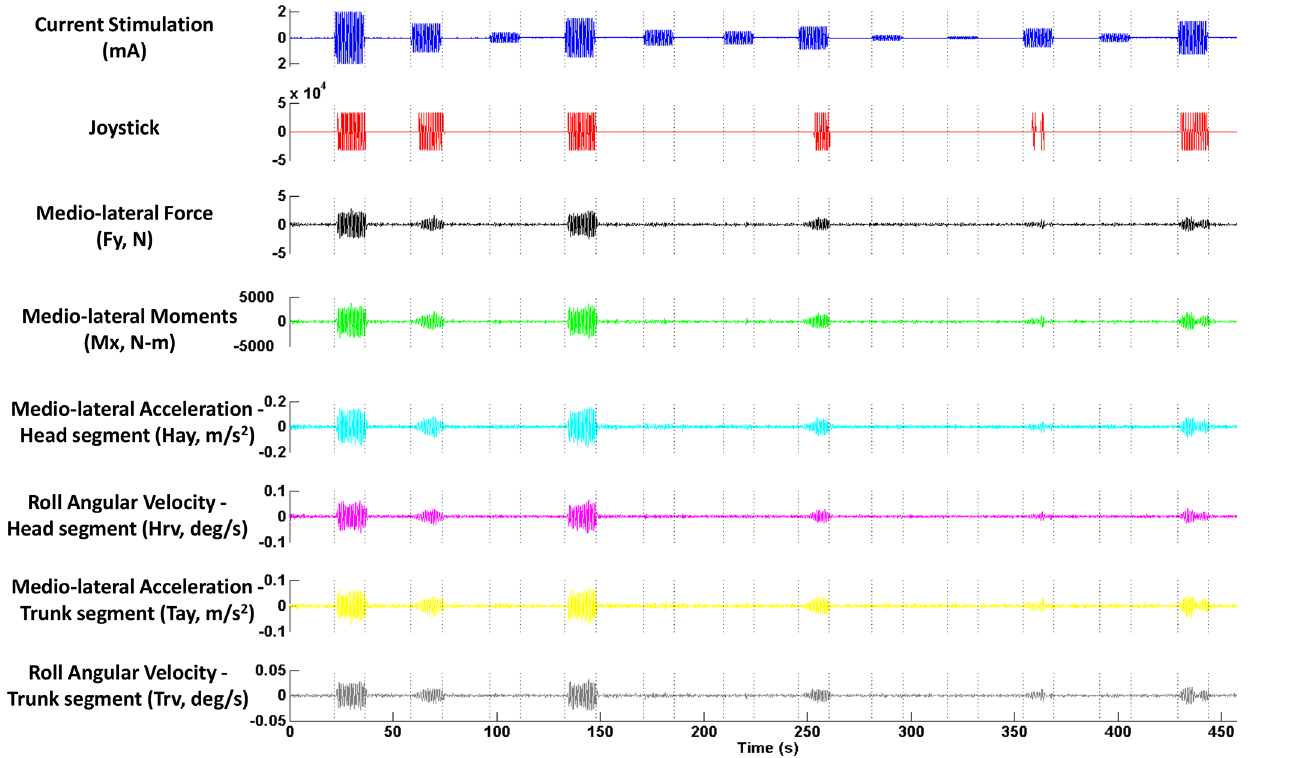
Fig 4. Exemplar plot of different measures of interest for a typical subject during the thresholding task. doi:10.1371/journal.pone.0136335.g004 obtained from the logistic function. Fig 5B show the threshold curves obtained using the six measurements of body motion (for the sake of clarity, the normalized percentage time of body